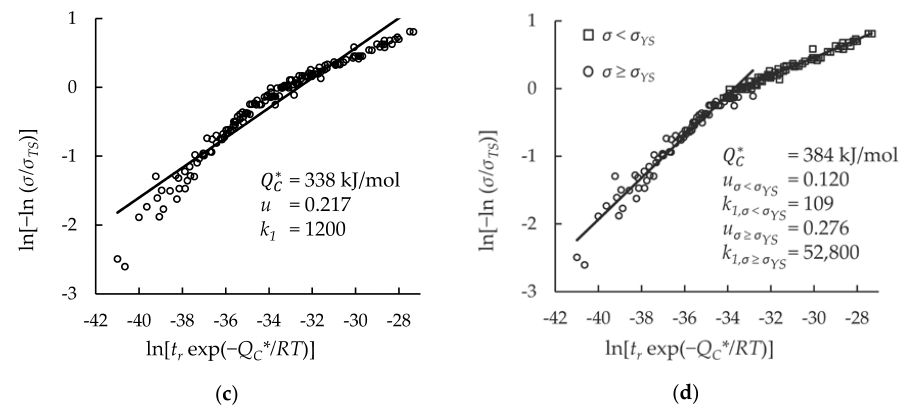
Figure 2. Goodness of fit of creep rupture data on Wilshire plots for: ( a ) HR6W data treated as a single region; ( b ) HR6W data split into above- and below-yield stress regions; ( c ) Sanicro 25 data treated as a single region; and ( d ) Sanicro 25 data split into above- and below-yield stress regions. Additionally, for the Sanicro 25 data set with all data, 𝐶𝐶∗ 𝑄𝑄 was determined as a function of σ / σ TS .